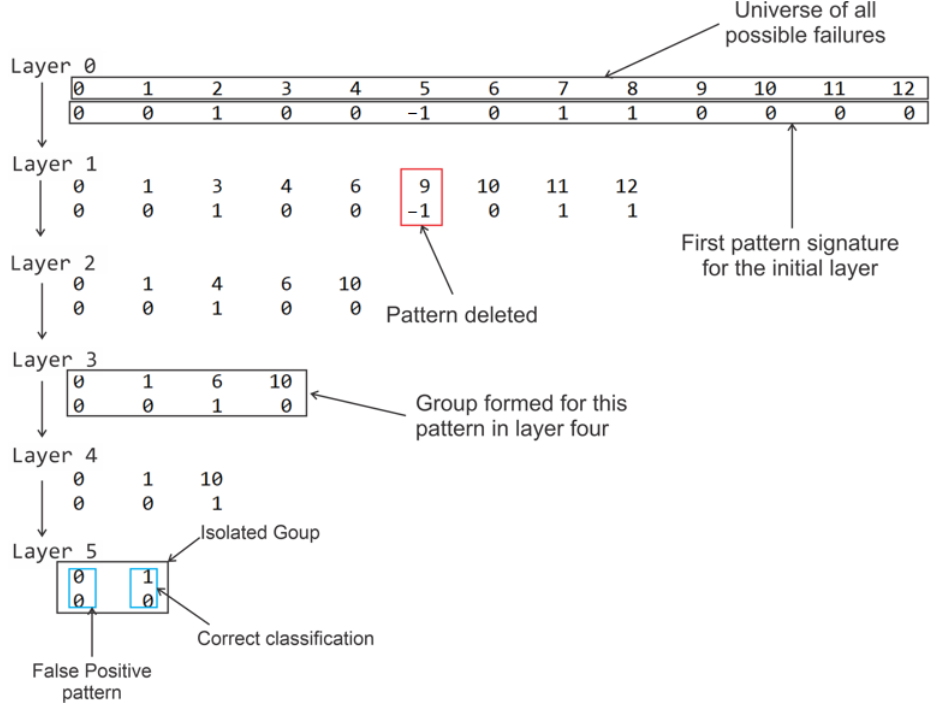
Figure 18. Fault isolation process with the construction of a decision tree for the standard with Fault F1 and Intensity